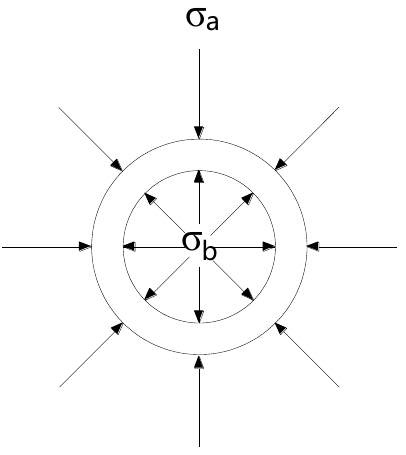
Figure 9. Thermal expansion diagram of coal matrix particle volume.